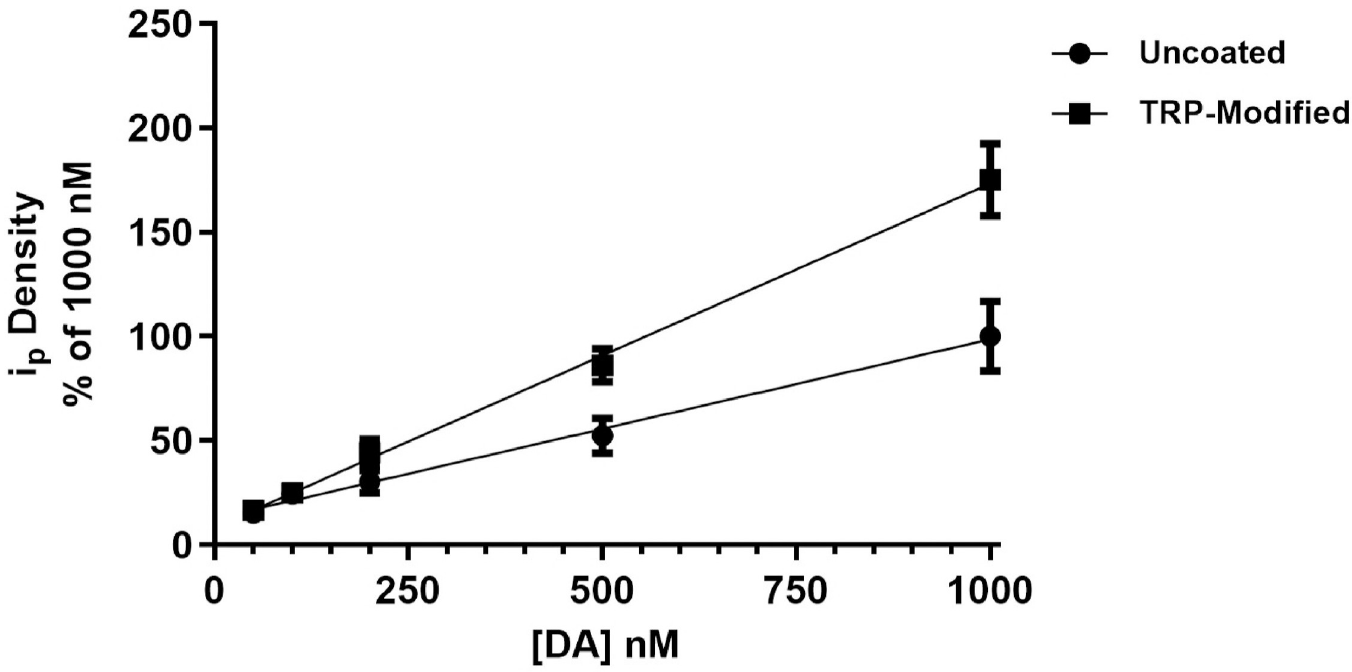
Fig 3. I p density for DA using uncoated and TRP-modified electrodes was plotted vs. known DA standards (50 nM, 100 nM, 200 nM, 500 nM, 1 μ M), n = 5 per group normalized to uncoated 1000 nM mean response. Slopes for the uncoated and TRP-modified curves are 0.0860 ± 0.0038 (nA � Q -1 � nM -1 ), and 0.1649 ± 0.0042 (nA � Q -1 � nM -1 ), respectively. ANCOVA showed that the slopes were significantly different (p <